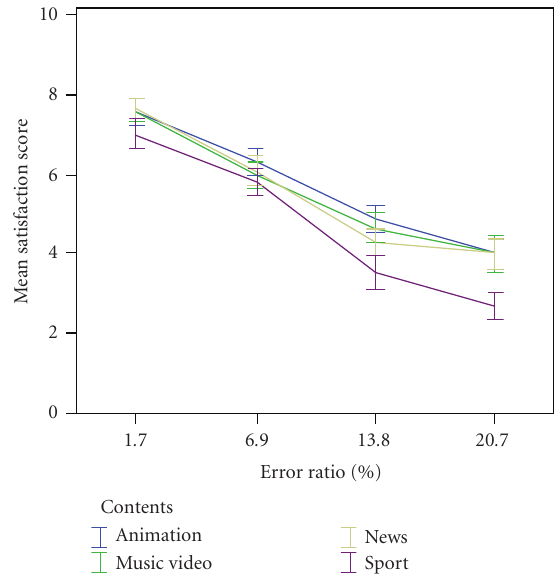
Figure 5: Mean satisfaction scores for all contents. Error bars show 95% CI of